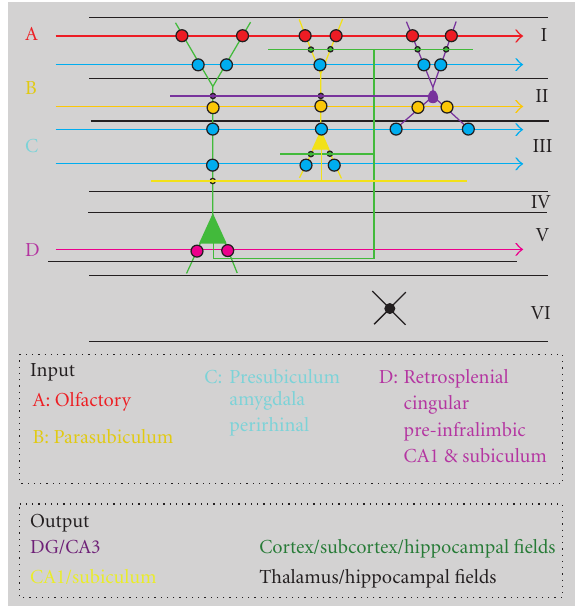
Figure 3: Schematic representation of laminar distribution and synaptic interactions between inputs and principle cells of the entorhinal cortex. Di ff erent inputs are represented by color- coded arrows; position of the arrows indicates the main laminar distribution. Circles indicate putative synaptic contacts between inputs and principle cells. Main output connectivity of principle cells is indicated as well. The figure emphasizes the integrative capacity of layer V